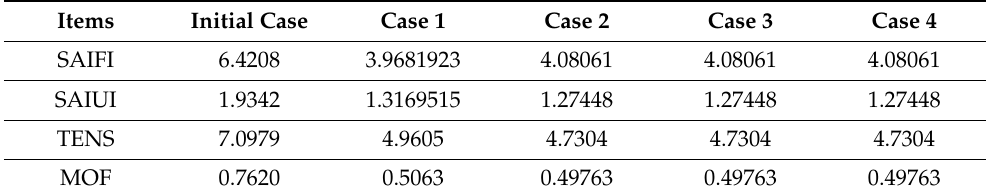
Table 2. Reliability Outcomes Based on The JFS Optimizer for The Cases Studied.